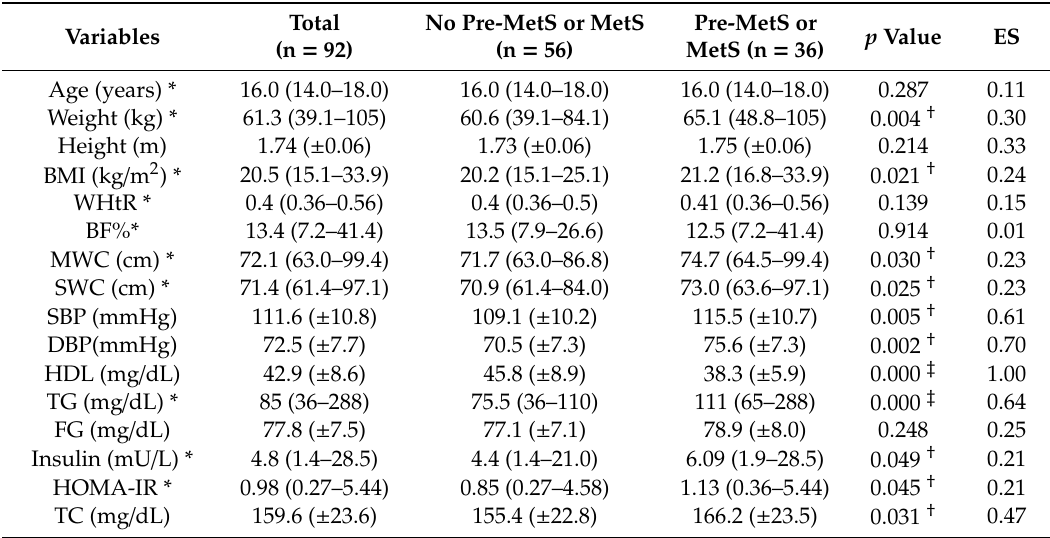
Table 1. Participants’ metabolic, anthropometric, and hemodynamic profile, with and without metabolic syndrome or pre-metabolic